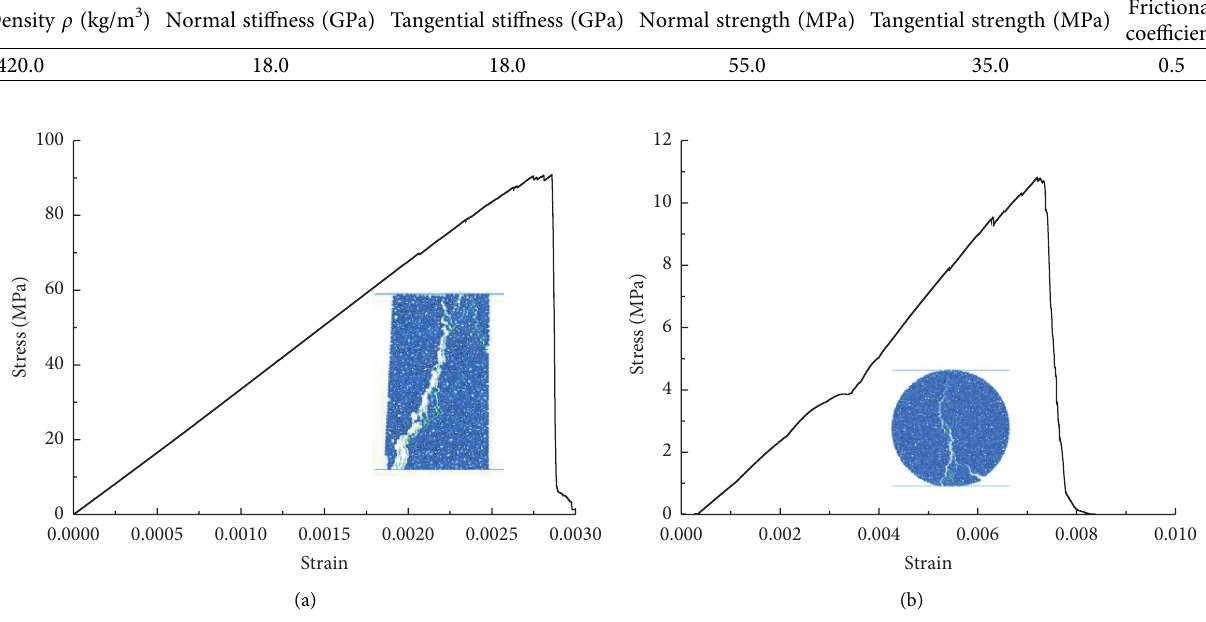
Table 2: Mesomechanical parameters of the particle flow model.